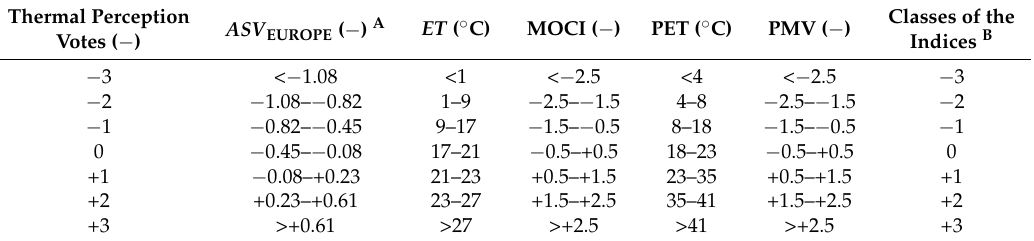
Table 2. Thermal perception votes and corresponding categories of the indices.